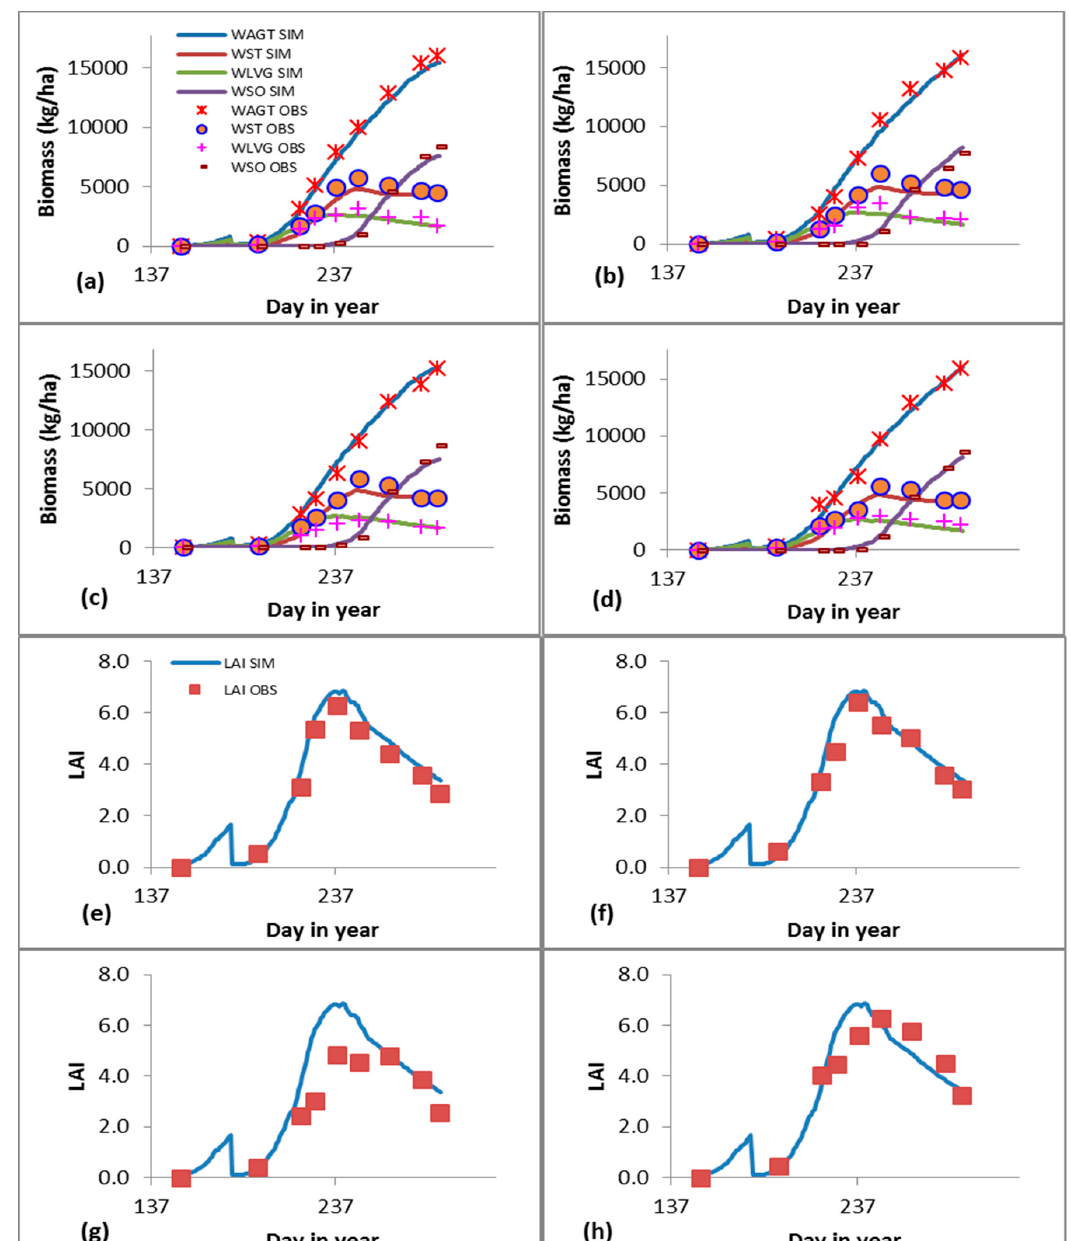
Figure 2. Simulated and observed total biomass (WAGT), green leaves (WLVG), stems (WST), storage organs/panicles (WSO) are presented in ( a , b , c , d ) and leaf area index (LAI) is presented in ( e , f , g , h ), for organs/panicles (WSO) are presented in ( a – d ) and leaf area index (LAI) is presented in ( e – h ), for validation period 2008, in Kunshan, Nanjing, China. validation period 2008, in Kunshan, Nanjing,